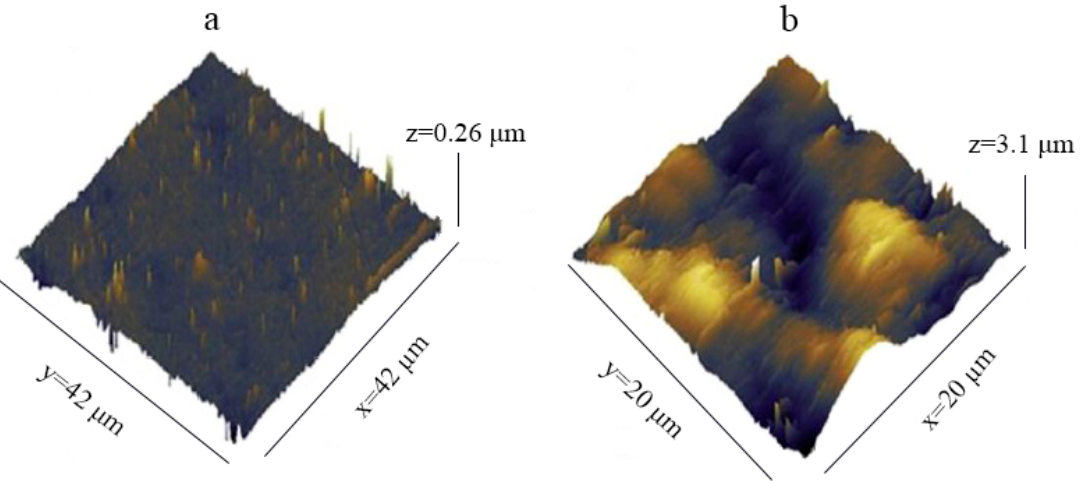
Figure 9. AFM images for (a) polished surface prior to boiling Ra = 5.1 nm and (b) surface after boiling 0.02 vol.% nanofluid, Ra = 376 nm. Adapted from Ciloglu and Bolukbasi. Reproduced from [77], Elsevier: 2015.